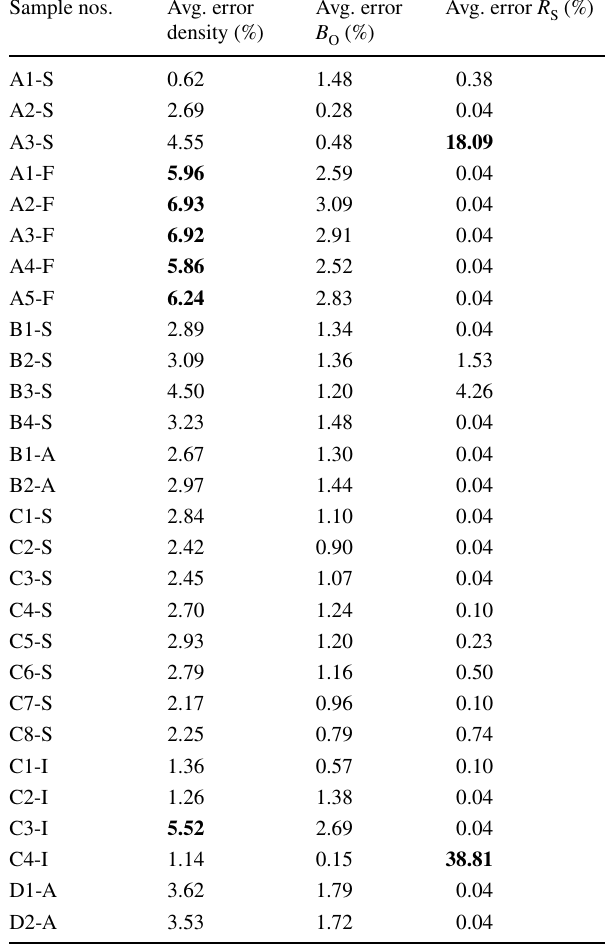
Fig. 27 Density check—separator test